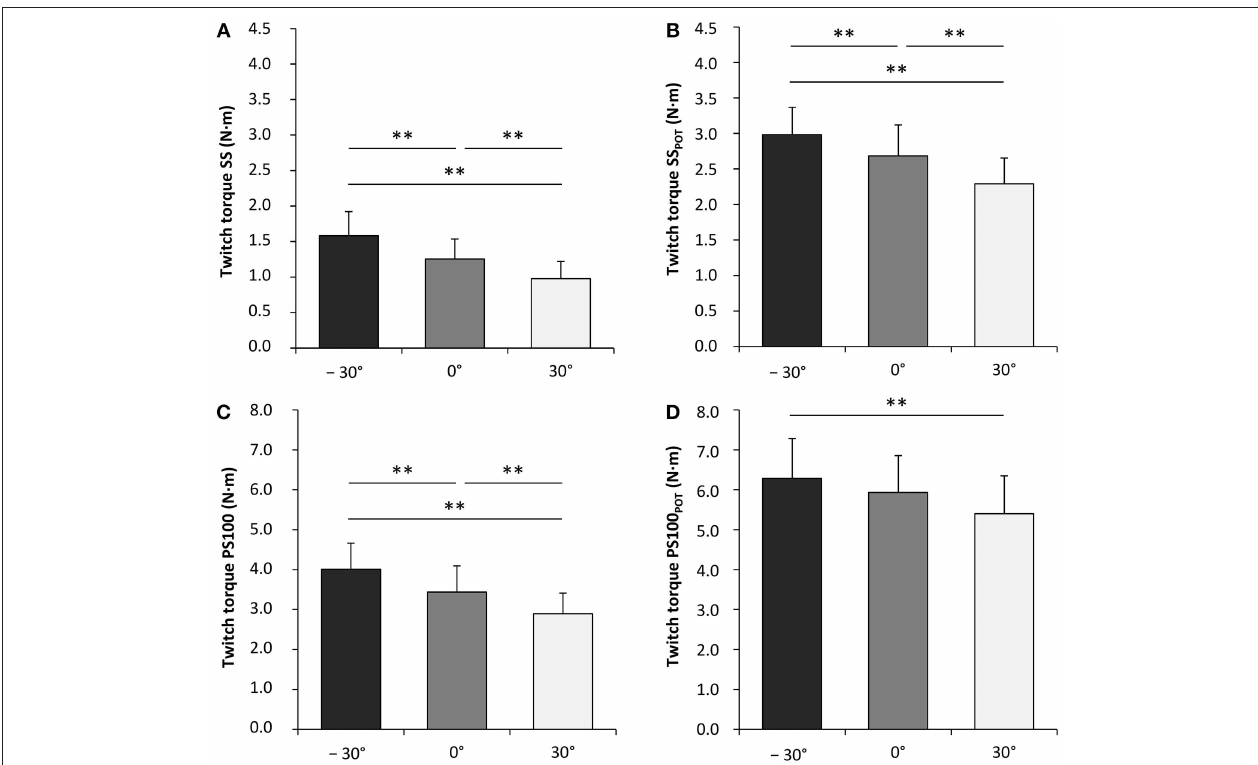
FIGURE 4 | Unpotentiated peak twitch torques evoked by single electrical stimuli [ss] (A) , potentiated peak twitch torques evoked by single electrical stimuli [SS POT ] (B) , unpotentiated peak twitch torques evoked by paired electrical stimuli at 100Hz [inter-stimulus interval (ISI) 10ms, PS100] (C) and potentiated peak twitch torques evoked by paired electrical stimuli at 100Hz (ISI 10ms, PS100 POT ) (D) . − 30 ◦ , extension: long wrist flexor muscle length; 0 ◦ , neutral: intermediate wrist flexor muscle length; 30 ◦ , flexion: short wrist flexor muscle length. *Denotes a significant difference between joint angles (** P ≤ 0.010). Values are expressed as means ± standard